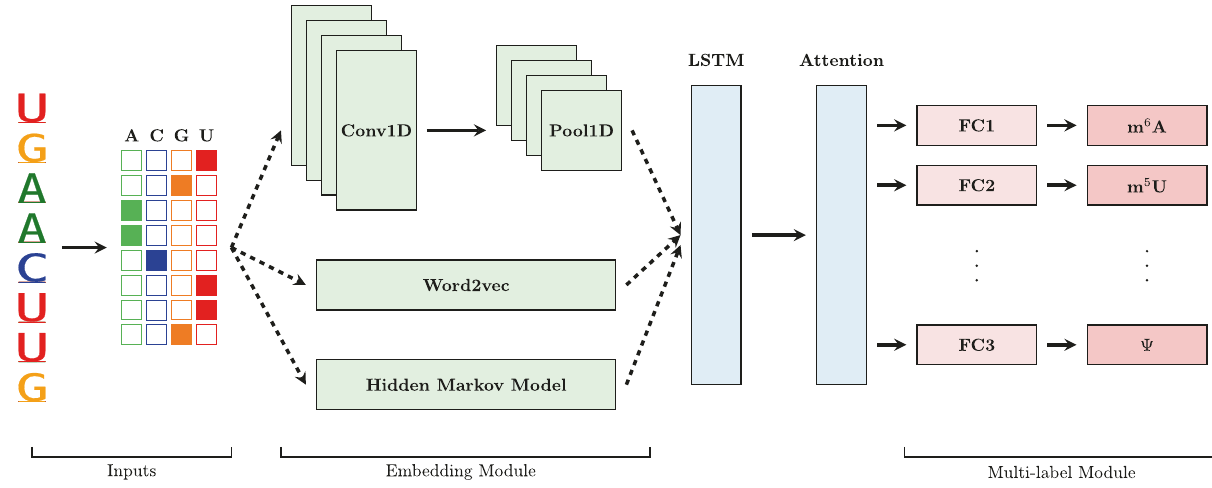
Fig. 1 A graphic illustration of the MultiRM model architecture. The model consists of an embedding module and an LSTM-Attention block to extract and learn useful features. Then, features fi ltered by attention are fed into a multi-label module to predict RNA modi fi cations simultaneously. Conv1D stands for 1D convolutional layer; Pool1D stands for 1D max-pooling layer; FC stands for fully connected